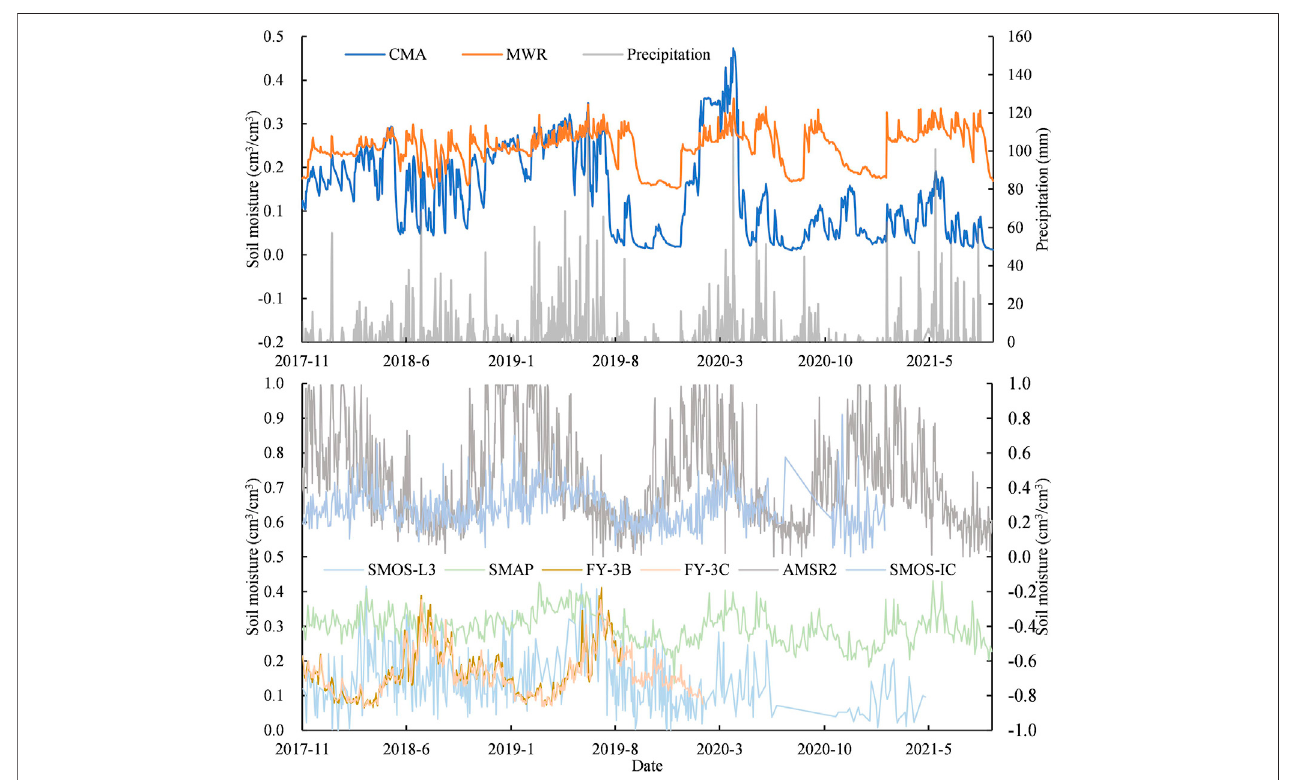
FIGURE2| Time-seriesdataofsoilmoisturebasedon insitu measurementdata,remotesensing – basedproducts,anddailyprecipitationattheYizhangstation. In situ measurement, SMOS-L3, SMAP, FY-3B, and FY-3C data correspond to the main axis (left). Daily precipitation, AMSR2, and SMOS-IC data correspond to the secondary axis